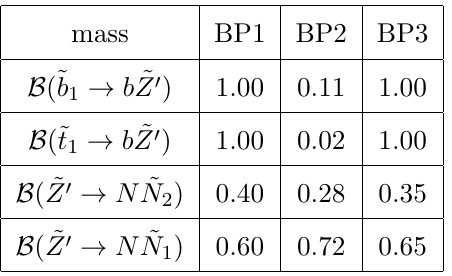
Table 3. Relevant Branching fractions in supersymmetric cascade decay for the benchmark